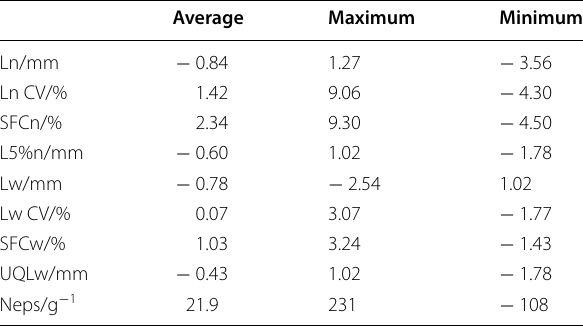
Table 7 Change in AFIS fiber properties after processing Average Maximum Minimum Ln/mm 0.84 −